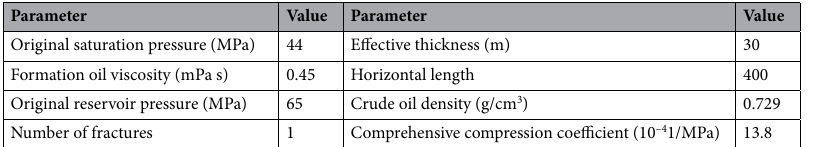
Table 1. Basic reservoir parameters.